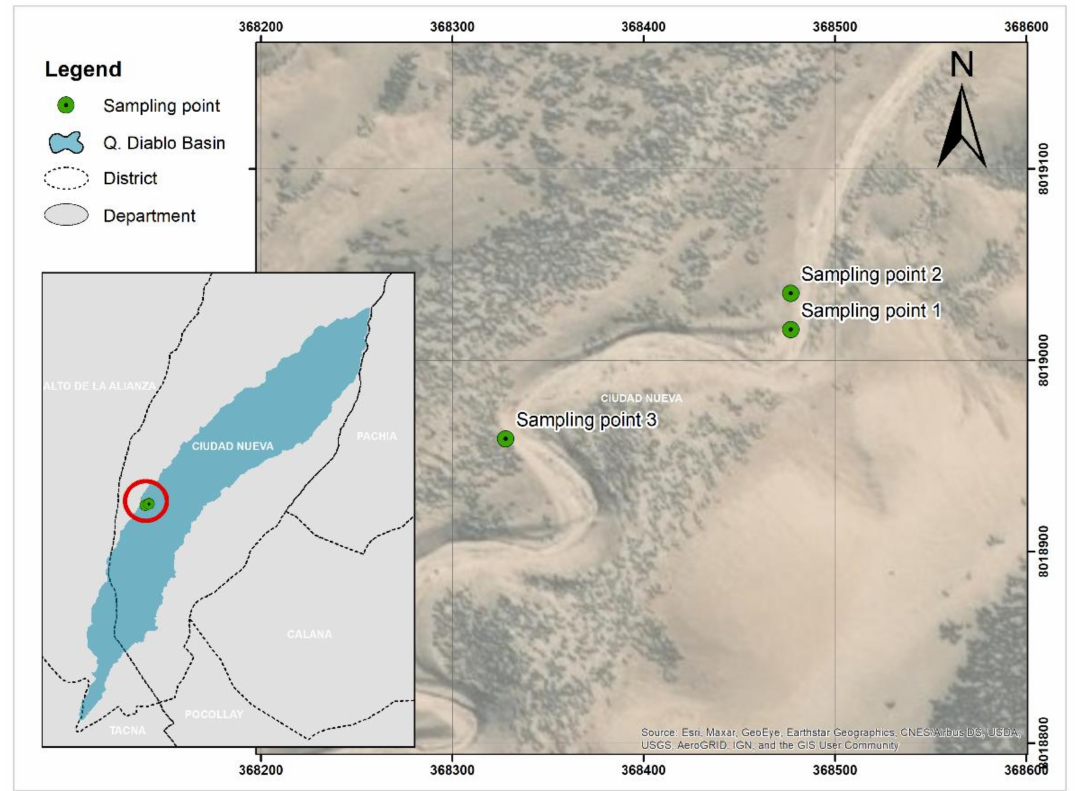
Figure 10. Location of soil sampling